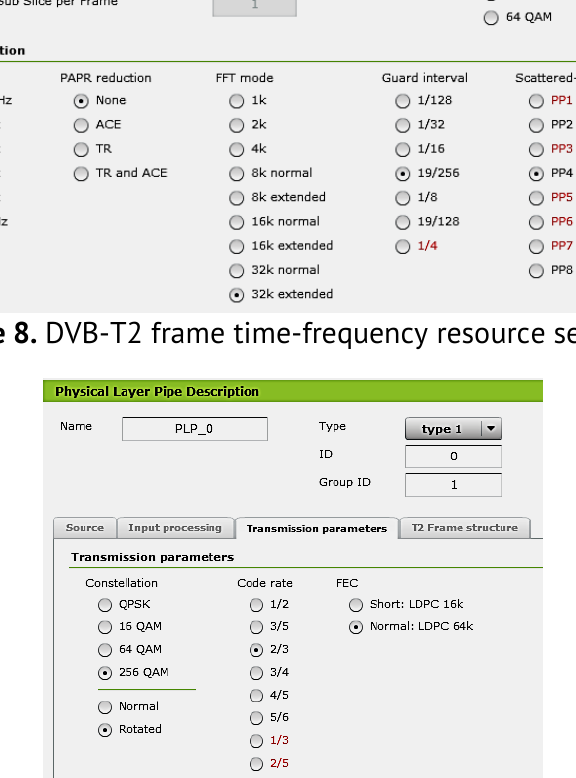
Figure 9. Physical Layer Pipe settings (PLP) of studied cluster.